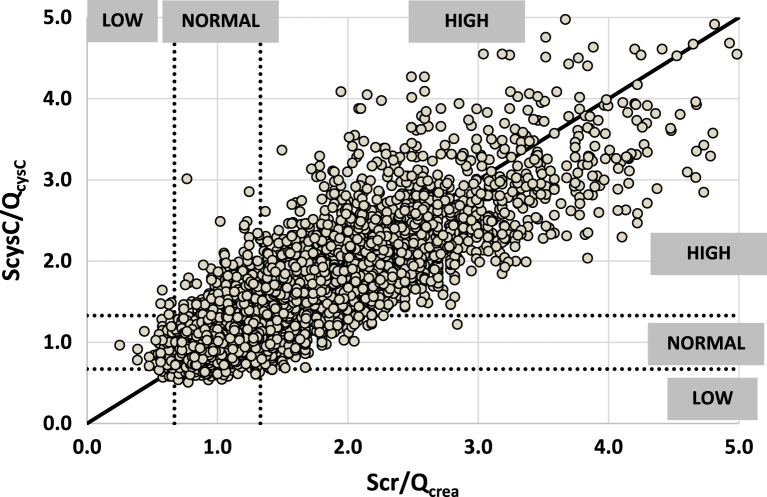
: Rescaled biomarker ScysC/QcysC against Scr/Qcrea for n=8584 subjects. The diagonal line is the identity line. The vertical and horizontal dotted lines correspond to ScysC/QcysC and Scr/Qcrea equal to 0.67 and 1.33 respectively and define the area of ‘normal’ biomarkers. Rescaled biomarker values < 0.67 are ‘Low’ and > 1.33 are indicated as ‘high’.